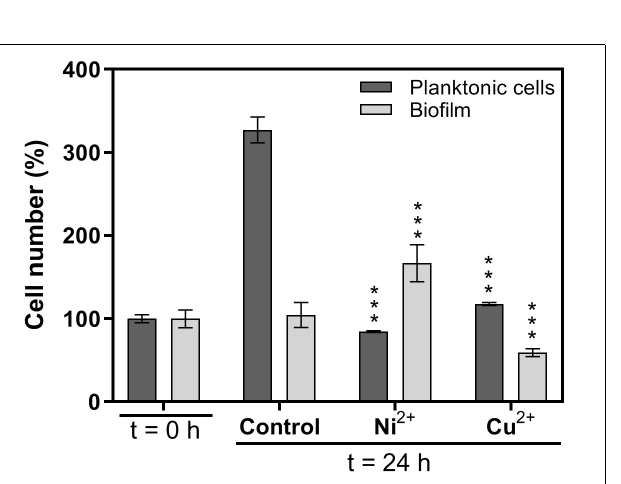
FIGURE 1 | Scanning electron microscopy (SEM) of H. salinarum biofilms without metal treatment (control) and after 24 h treatment with 5 mM copper or 40 mM nickel ions.